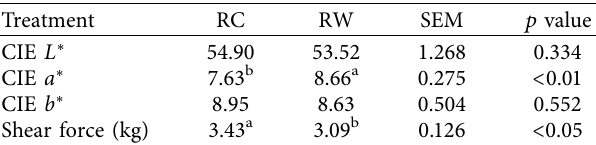
Table 4: Shear force and color (CIE) of raw pork loin from pigs fed a whey powder-supplemented diet. Treatment